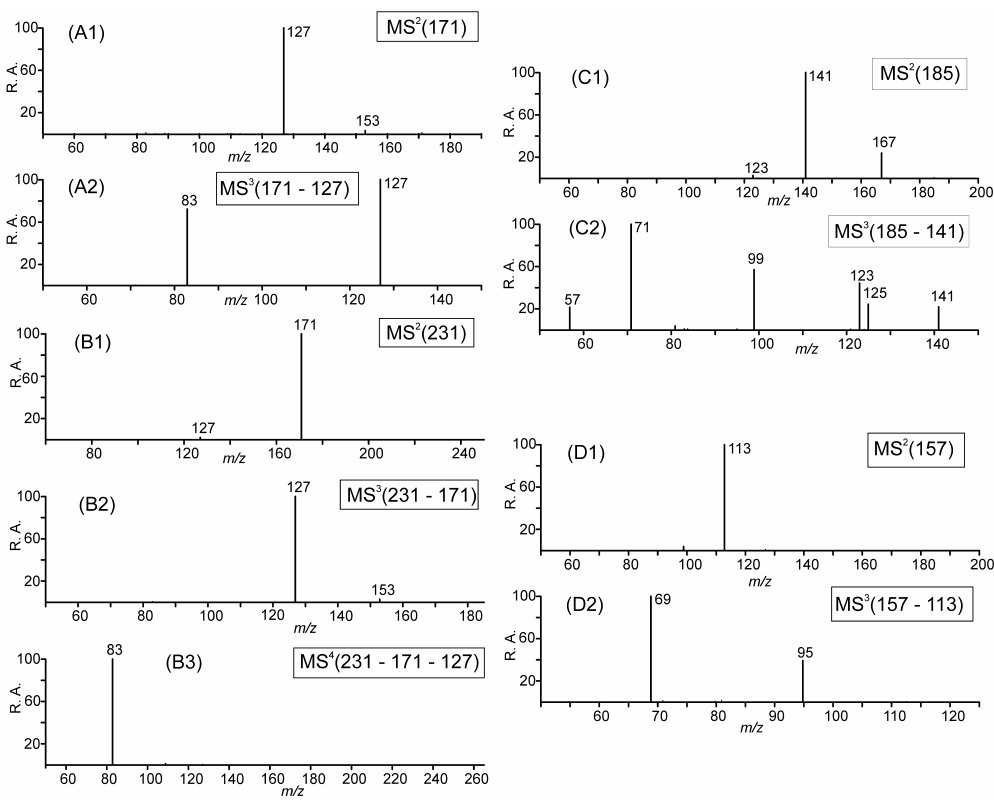
Fig. 3. ( − )ESI-MS data for authentic reference compounds of (A) terpenylic acid, (B) diaterpenylic acid acetate, (C) cis -pinic acid, and (D) terebic acid.